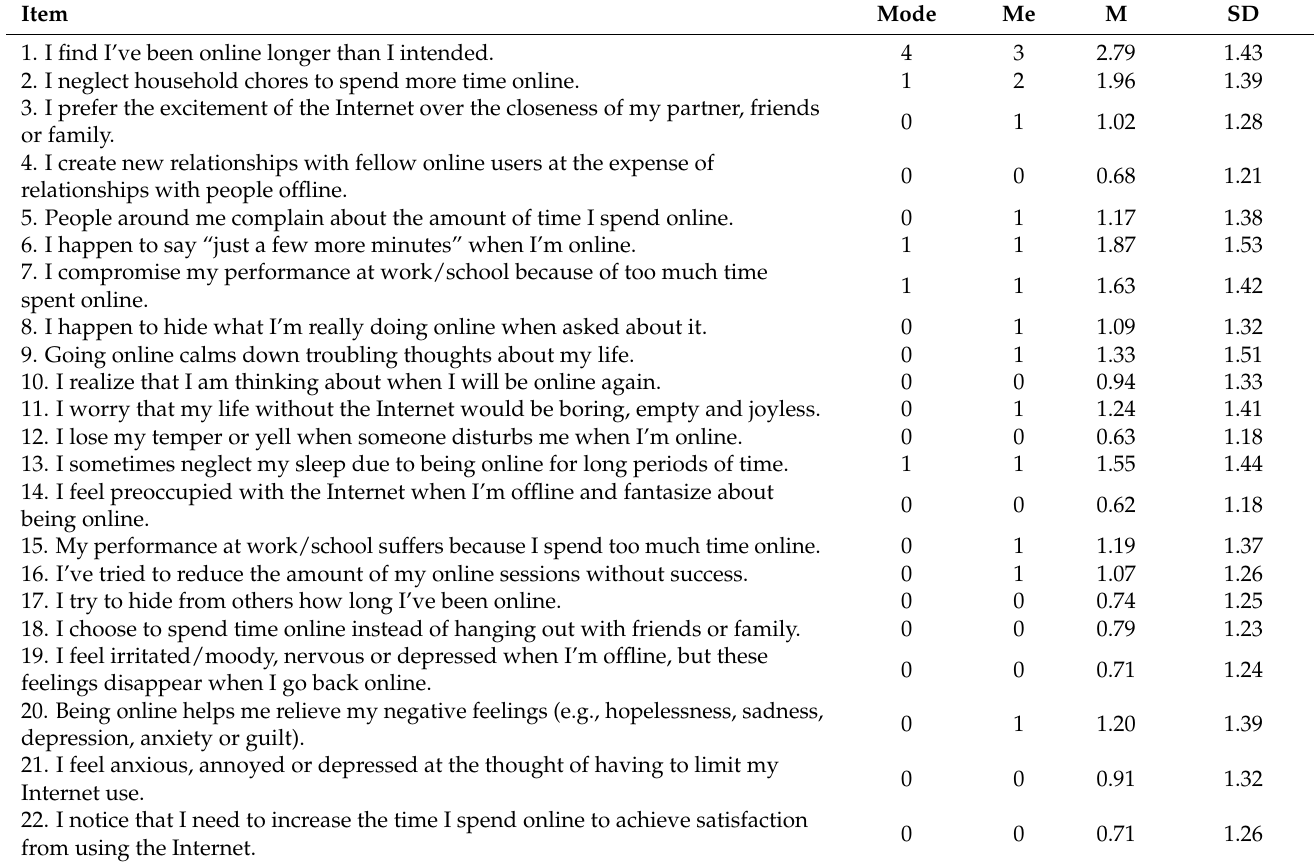
Table 3. Respondents’ responses to individual questions on the TPUI22 questionnaire.